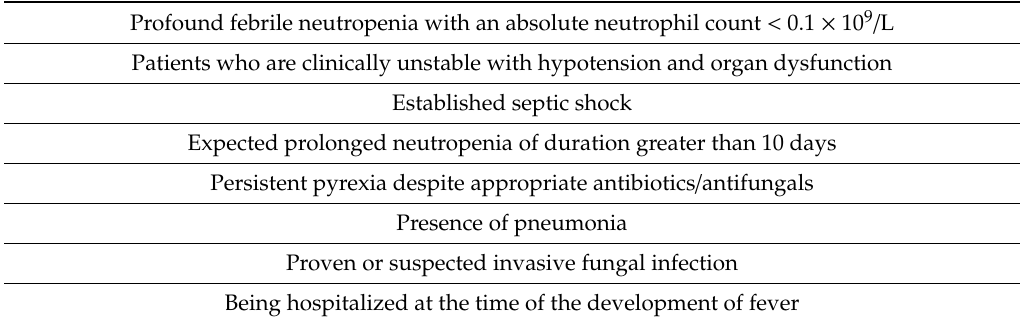
Table 3. Complicated febrile